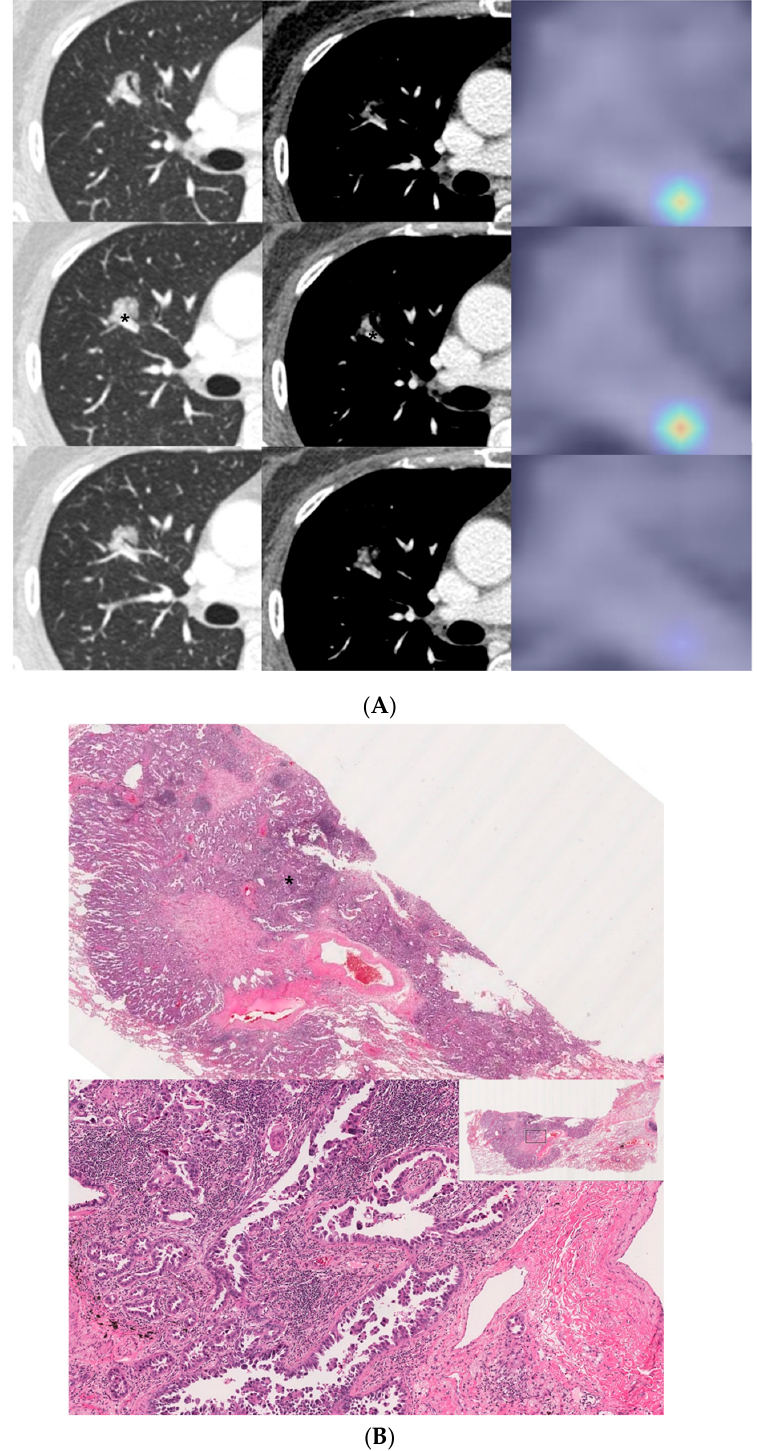
Figure 4. A 57-year-old female with invasive lung adenocarcinoma (Acinar 90%, MP 1%, Scar 9%). ( A ) A 13 mm part-solid nodule with air-bronchograms is noted in right upper lobe. The activation map is shown as a heatmap, highlighting the most important region when it classified the given lesion as MPSol (micropapillary or solid pattern). A very focal highlighted region (marked with an asterisk) is noted in the proximal portion of the tumor, adjacent to a transversing vascular structure. ( B ) Surgical pathology demonstrates a micropapillary histologic pattern (marked with an asterisk) adjacent to the vascular structure in the tumor which corresponds to the activation map.